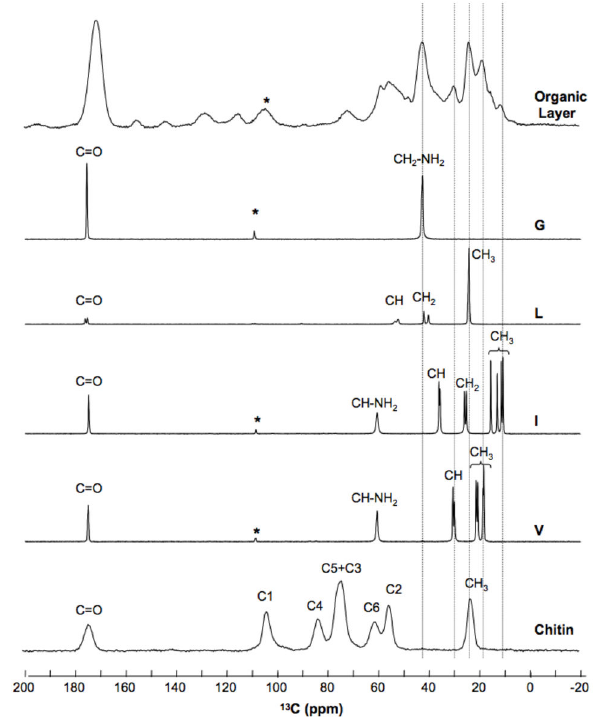
Figure 3. { 1 H} 13 C CPMAS spectrum of the organic layer of Notodiscus hookeri shells. The spectrum of the organic layer of shells originating from Branca site are compared to the spectra of ß-chitin powder and to the most abundant L-amino acids found in this layer (G = glycine, L = leucine, I = isoleucine and V = valine). The major peaks of the organic layer can be ascribed to each amino acid, as shown by the dotted lines. The chitin signature, indicated by the C1 to C6 carbon ions, is not detected in the organic layer. Asterisks (*) represent spinning